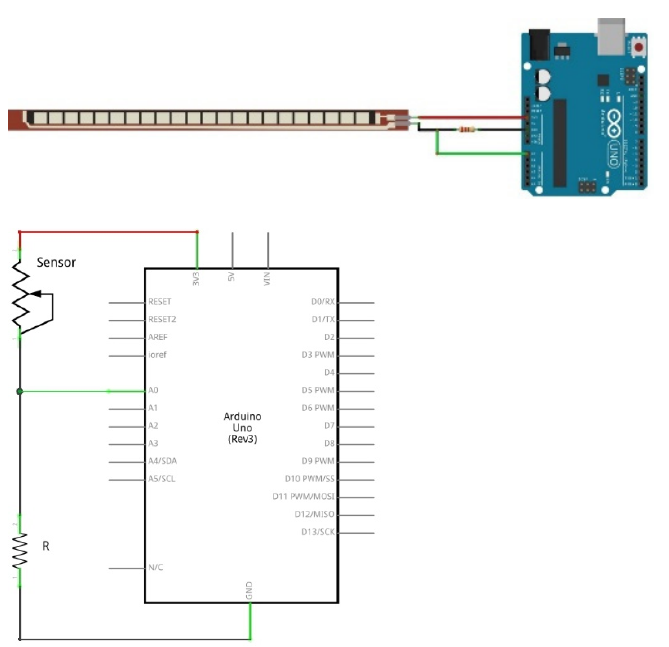
Figure 11. Arduino-sensor circuit for the test bench.